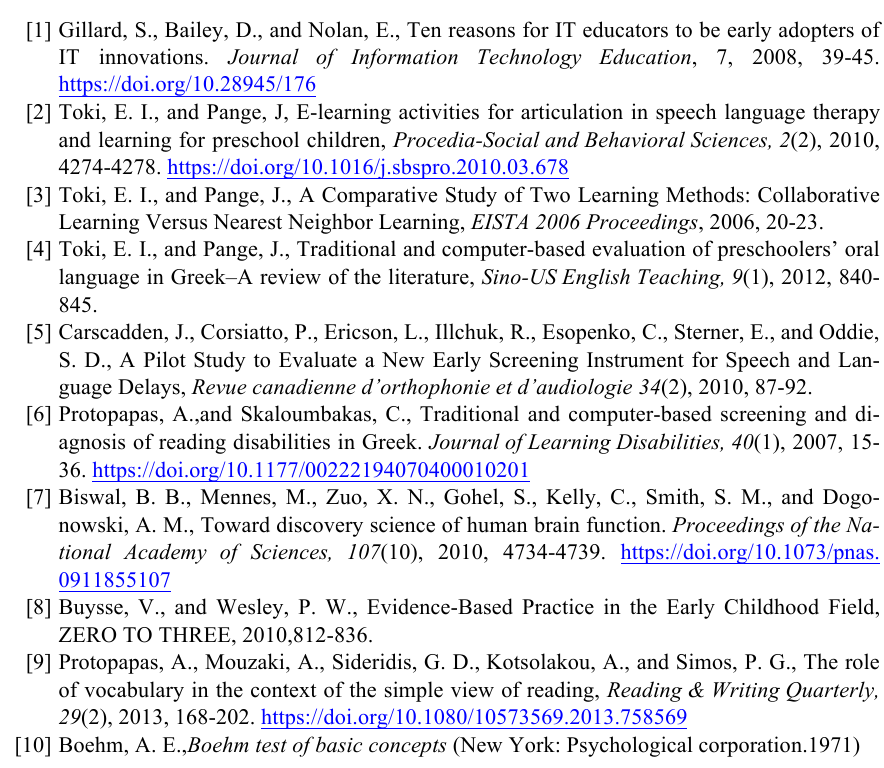
Short Paper— Screening Tools for Kindergarten